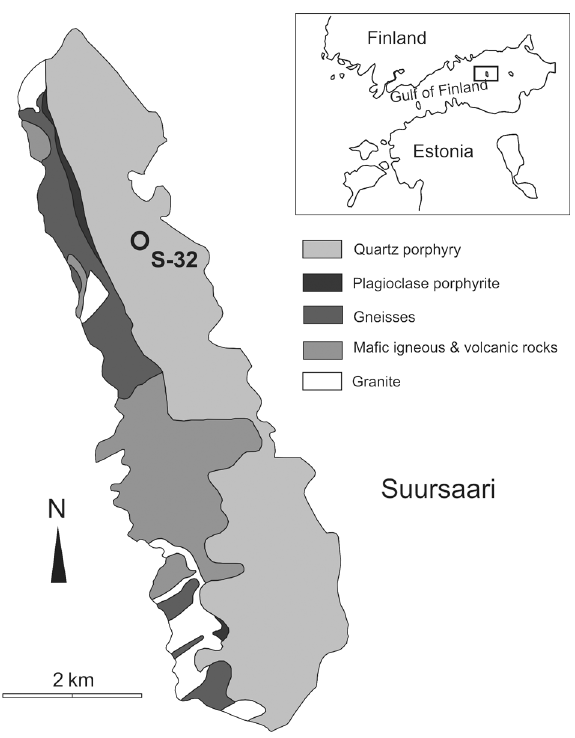
Fig. 1. Geological sketch map of Suursaari (after unpublished materials of H. Koppelmaa, M. Niin and J. Kivisilla, 1970, available in Nironen 2006) and location of sample